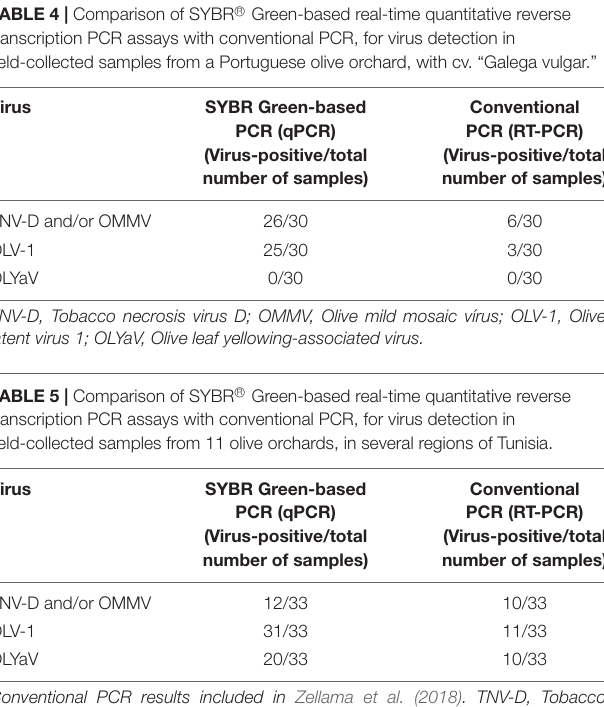
Conventional PCR results included in Zellama et al. (2018). TNV-D, Tobacco necrosis virus D; OMMV, Olive mild mosaic vírus; OLV-1, Olive latent virus 1; OLYaV, Olive leaf yellowing-associated